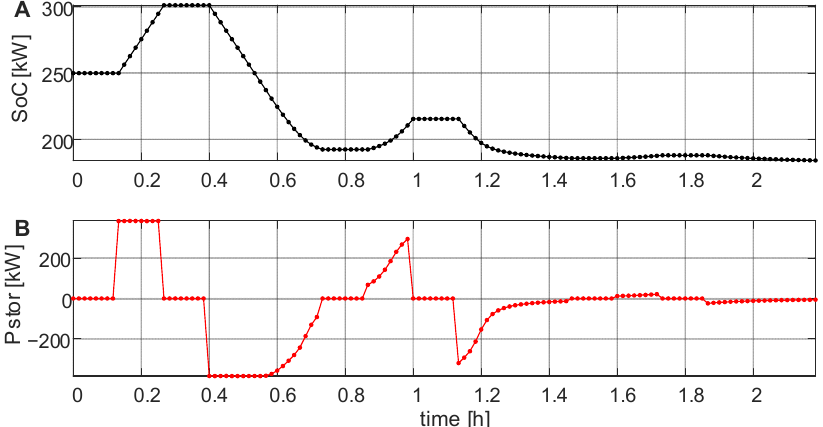
Figure 12. Operation resulting from the charging and discharging characteristics of the BESS with the real characteristics; change of energy accumulated in the BESS over time ( A ); change of BESS charging and discharging power over time ( B ).